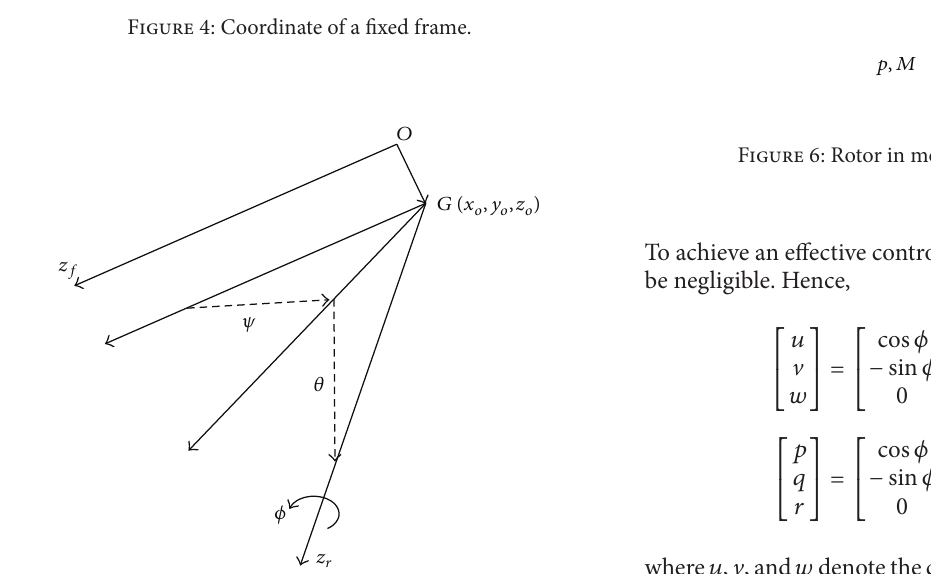
Figure 5: Coordinates of a rotor.